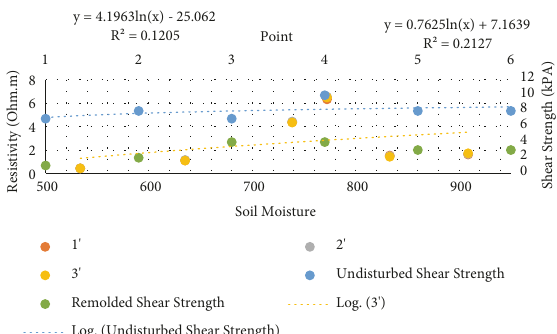
Figure 5: Soil Resistivity and soil shear strength vs soil moisture.